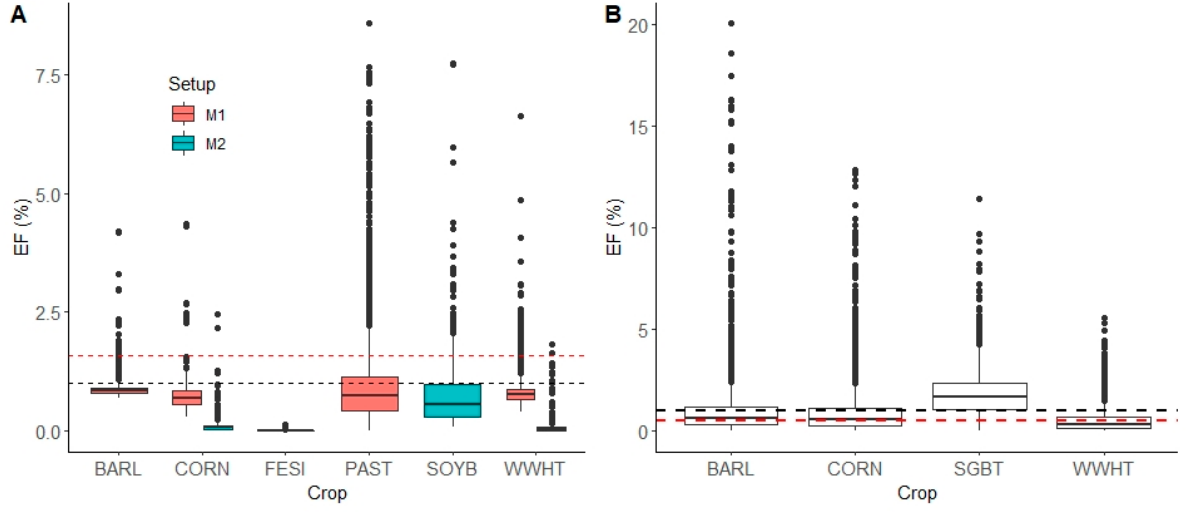
Figure 11. Boxplots of the simulated N 2 O EFs from the main crops in the Melk ( A ) and Zaya ( B ) catchments for all HRUs for 2006–2015. The boxplot shows the median with hinges on the 25% and 75% quantiles. The black dashed line indicates the aggregated IPCC default N 2 O EF value 1%. The red dashed line in ( A ) indicates the disaggregated IPCC default N 2 O EF for wet climate (1.6%) and in ( B ) indicates disaggregated IPCC default N 2 O EF value 0.5% for dry climate. The crops included in BARL (spring barley), CORN (grain corn), FESI (intensively managed pasture), PAST (pasture), SOYB (soybean), WWHT (winter wheat), and SGBT (sugar beet) are listed in Tables S2–S4. The median simulated N 2 O EFs in the Melk catchment in the M1 and M2 setups are lower than the aggregated and disaggregated IPCC default values (Figure 11A). Particularly, the N 2 O EFs with M2 setup are much lower than the N 2 O EFs. The median simulated N 2 O EFs in the Zaya catchment for BARL, CORN and WWHT were between the aggregated and disaggregated IPCC values and showed fairly good agreement with the IPCC